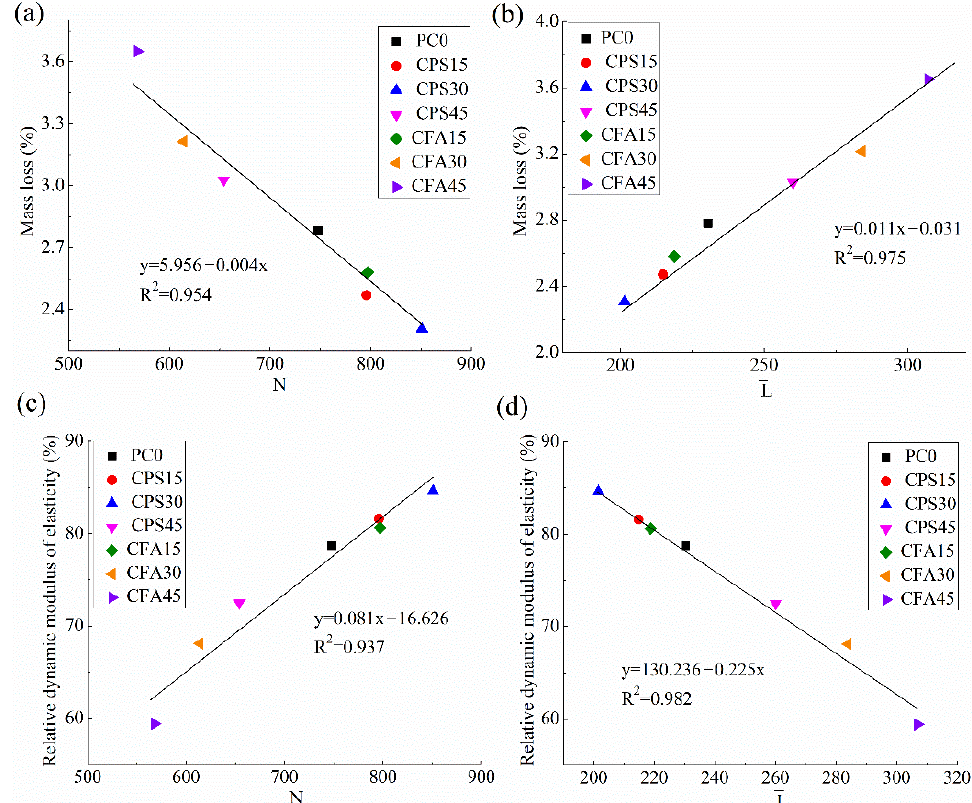
Figure 7. The correlation between frost resistance and air void structure: ( a ) mass loss and N, ( b ) mass loss and L̅ , ( c ) relative dynamic elastic modulus and N and ( d ) relative dynamic elastic modulus and L̅ .